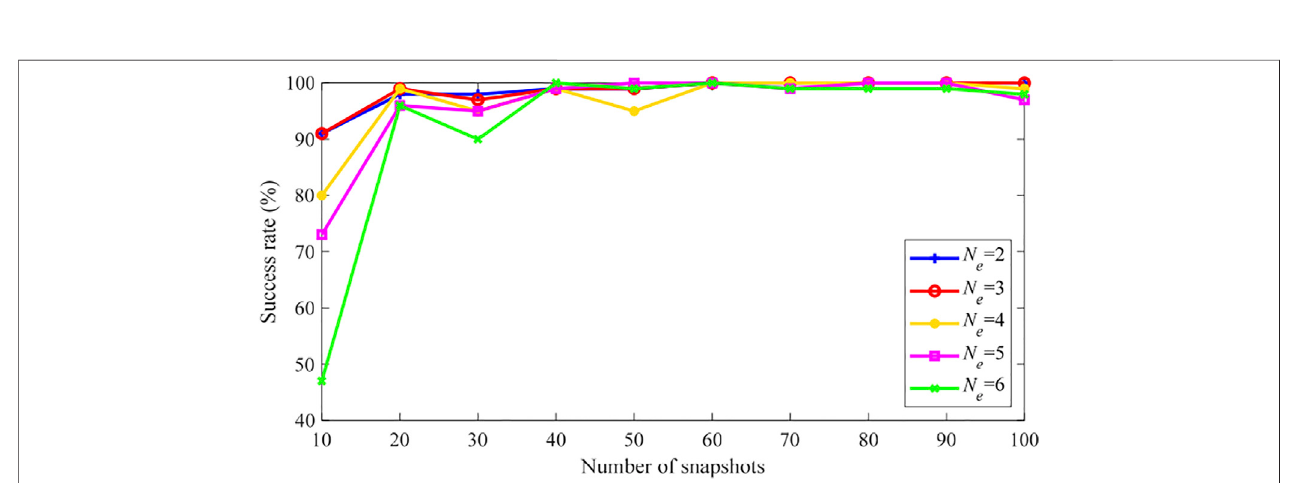
FIGURE 6 | PEI success rate of the IEEE 30-bus system (Case 2, 1 missing).